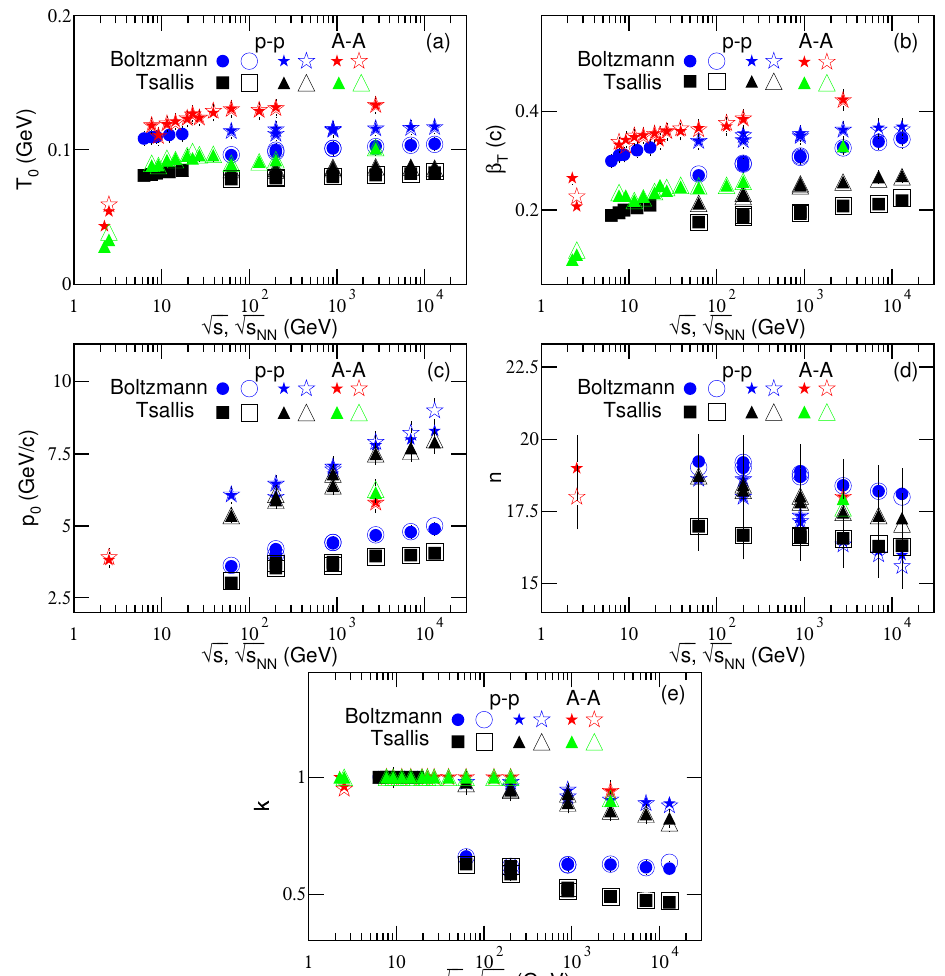
Figure 2. Excitation functions of ( a ) T 0 , ( b ) β T , ( c ) p 0 , ( d ) n , and ( e ) k . The closed (open) symbols represent the parameter values corresponding to π − ( π + ) spectra, which are listed in Tables 1 and 2. The blue circles (black squares) represent the first set of parameter values obtained from Equation (7) through Equations (1)–(3). The blue asterisks (black triangles) represent the second set of parameter values obtained from Equation (7) through Equations (1)–(3). The red asterisks (green triangles) represent the parameter values from AA collisions for comparisons, which are listed in Tables A1 and A2 in the Appendix